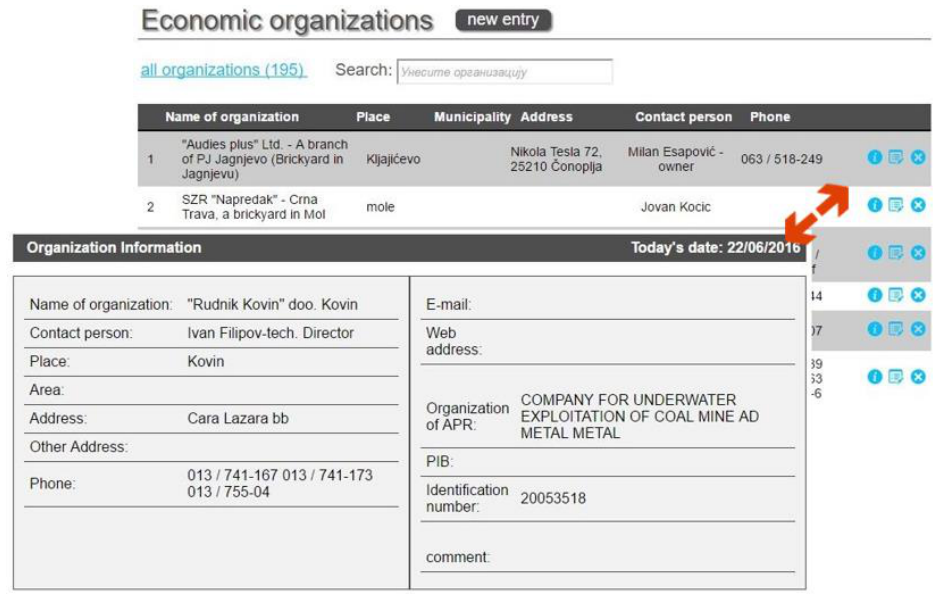
Figure 3. Data management for stakeholder data.